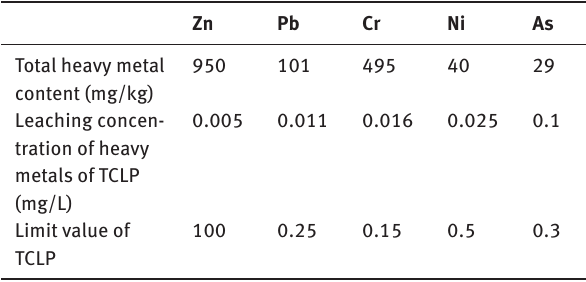
Table 3: Heavy metal content of original sludge.